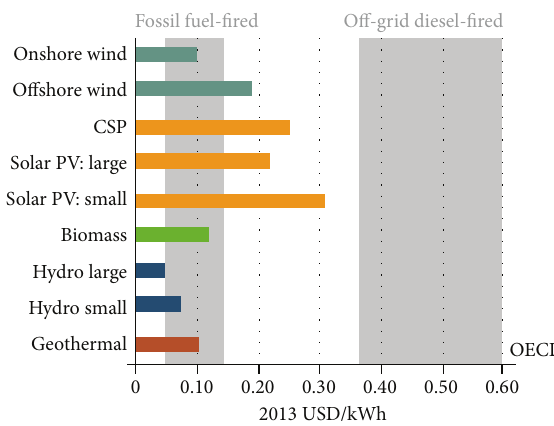
Figure 1: Total electricity cost (source: International Renewable Energy Agency, REthinking Energy: Towards a new power system, 2014)